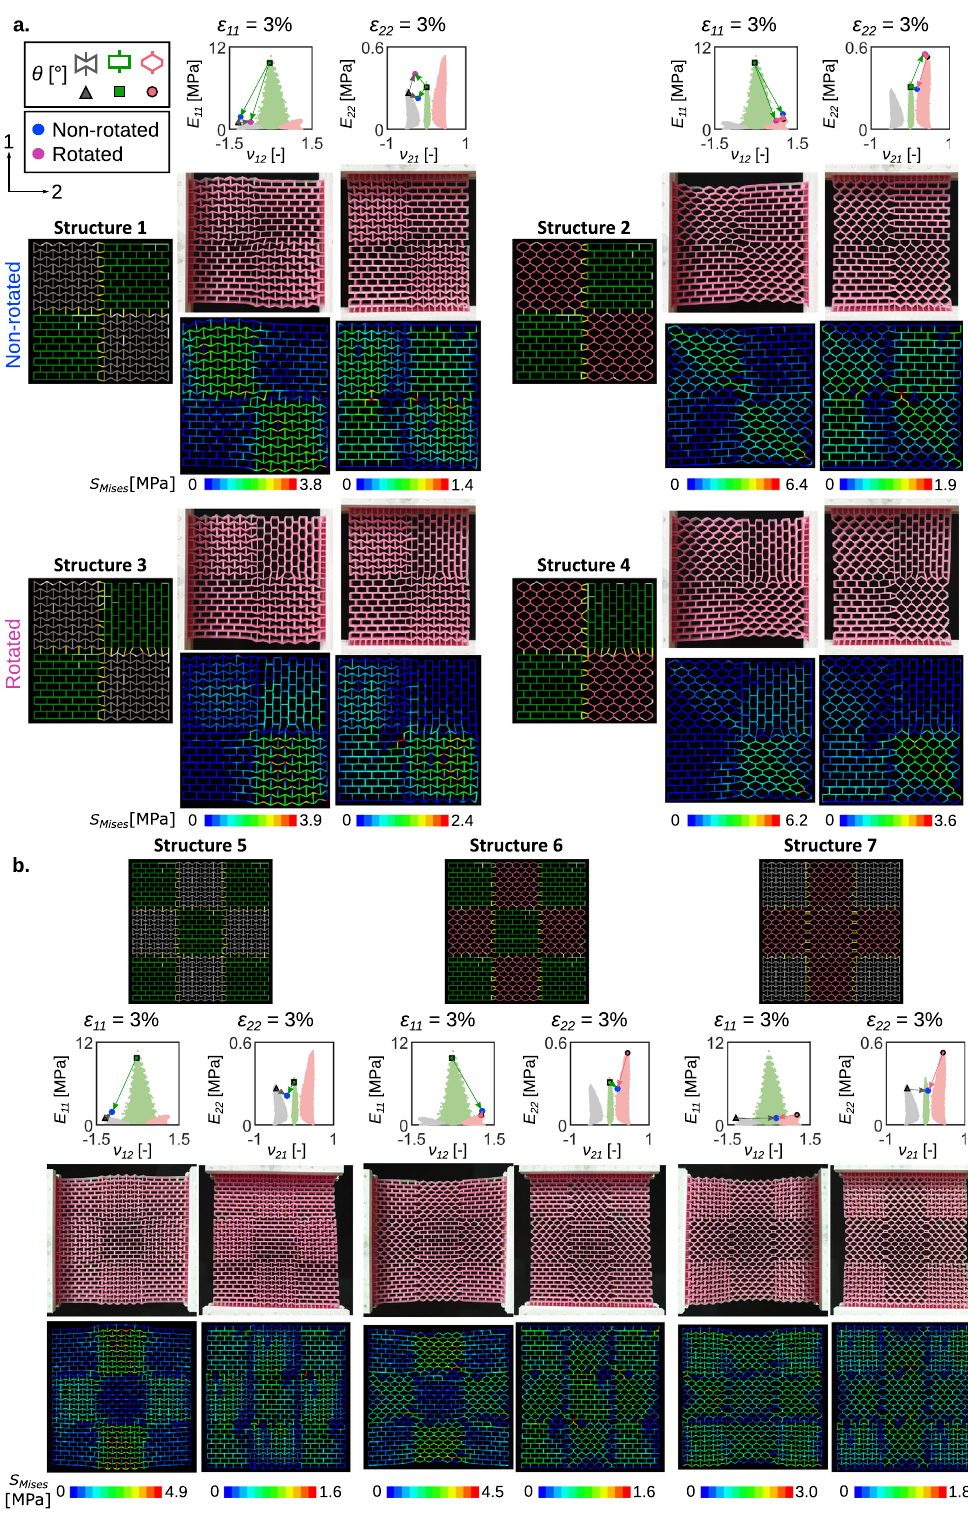
Fig. 3 Different combinations of designs with extreme mechanical properties. These designs are selected from each group of the unit cells (i.e., a re- entrant structure with a highly negative Poisson ’ s ratio, a honeycomb structure with a highly positive Poisson ’ s ratio, and an orthogonal structure with a high value of the elastic modulus). a The mechanical properties of two four-tile structures with non-rotated and rotated tiles and the distribution of the von Mises stresses in these lattice structures. These multi-material 3D printed specimens were mechanically tested in both the 1- and 2-directions under 3% tensile strain and the experimental results were compared with the FE simulation results (Table 1). b The mechanical properties of nine-tile combinations and the von Mises stress distribution in these combinations. These multi-material 3D printed specimens were mechanically tested in both the 1- and 2-directions under 3% tensile strain, and the experimental results were compared with the FE simulation results (Table